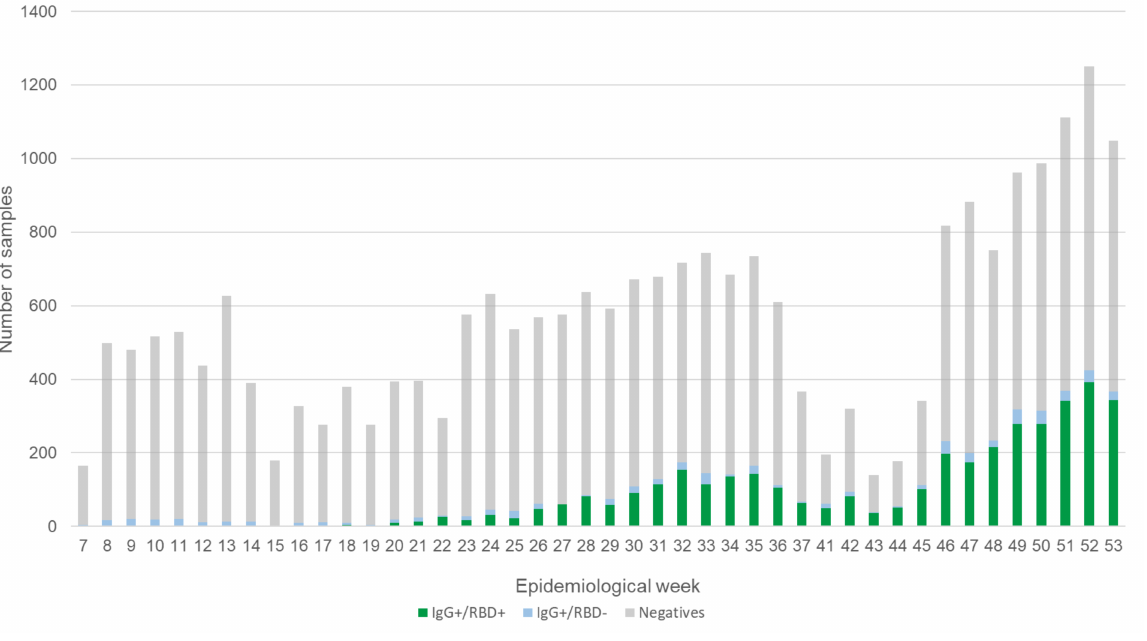
Figure 1. General result of the analyzed samples. The figure shows the total of samples analyzed in each of the weeks included in the study, as well as the results obtained for the IgG detection and neutralization (RBD)